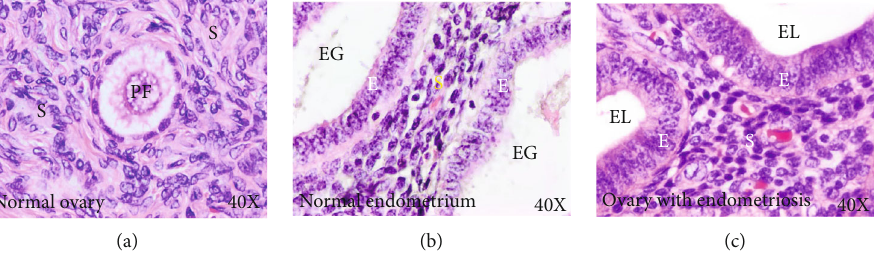
Figure 1: Microscopic presentation of normal ovary and ovary with endometriosis. (a) Section of a normal ovary showing a primordial follicle (PF) embedded in the ovarian stroma (S). (b) Section of normal endometrium showing closely packed endometrial glands (EG) containing a single layer of epithelium (E) arranged in the stroma. (c) Section of an ovary with endometriosis showing lesions with closely packed glands displaying a single layer of epithelium similar to endometrial glands present in normal endometrium. E =epithelium; EG=endometrial glands; EL =endometriotic lesion; PF=primordial follicle; S =stroma; 40x =magni fi cation.